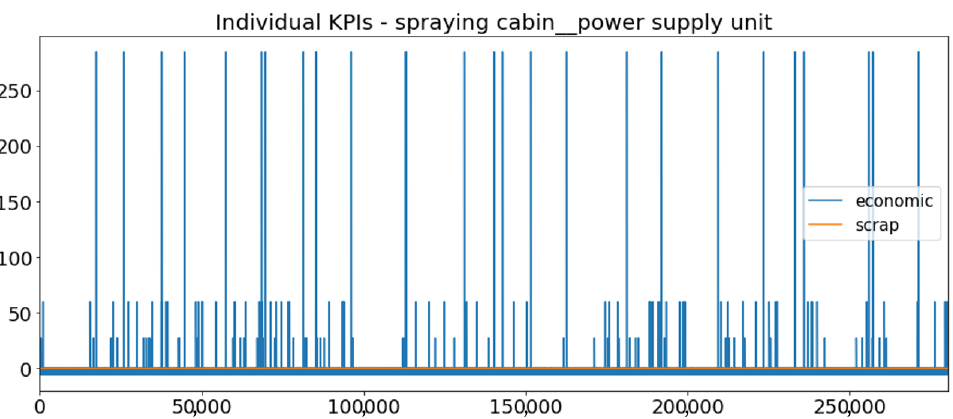
Figure 3. Individual KPI time series for the power supply unit yielded from running the model for the spraying cabin (GORENJE). The simulation interval has a length of 8 years.